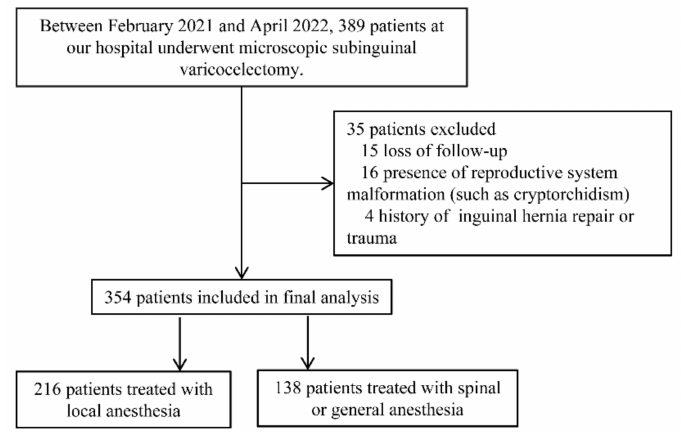
Figure 1. Flowchart of the